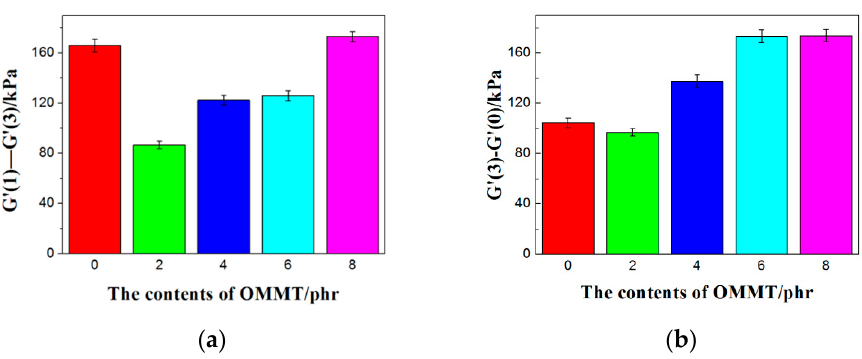
Figure 4. ( a ) G’ (1)-G’ (3) and ( b ) G’ (3)-G’ (0) of CB/NR composites with different contents of